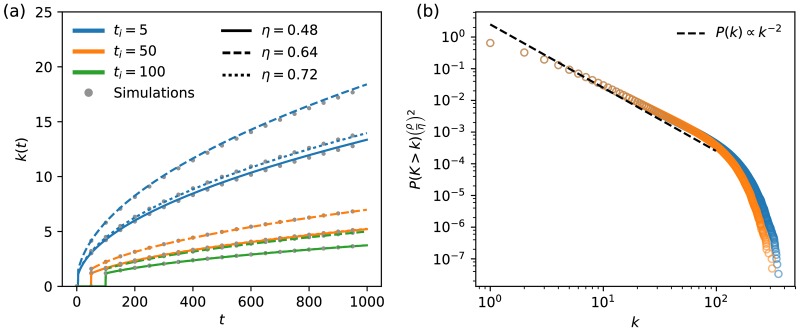
Agreement of theoretical predictions of network growth under the null model with simulations for several different choices of parameters.